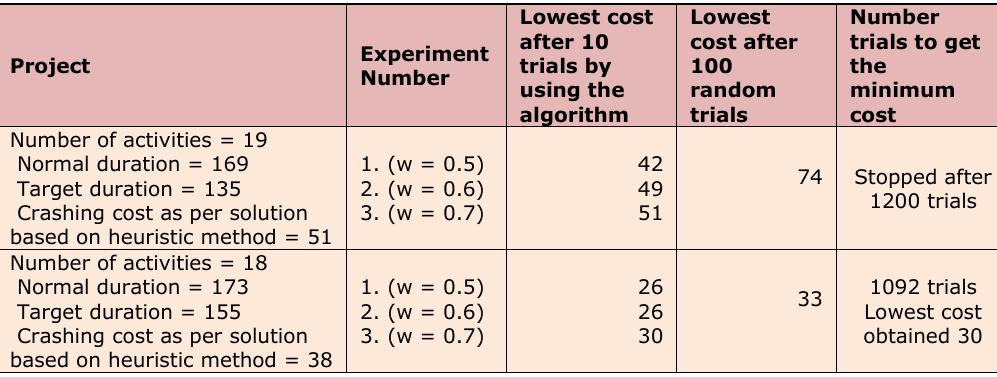
Table 6. Result of Application on two more